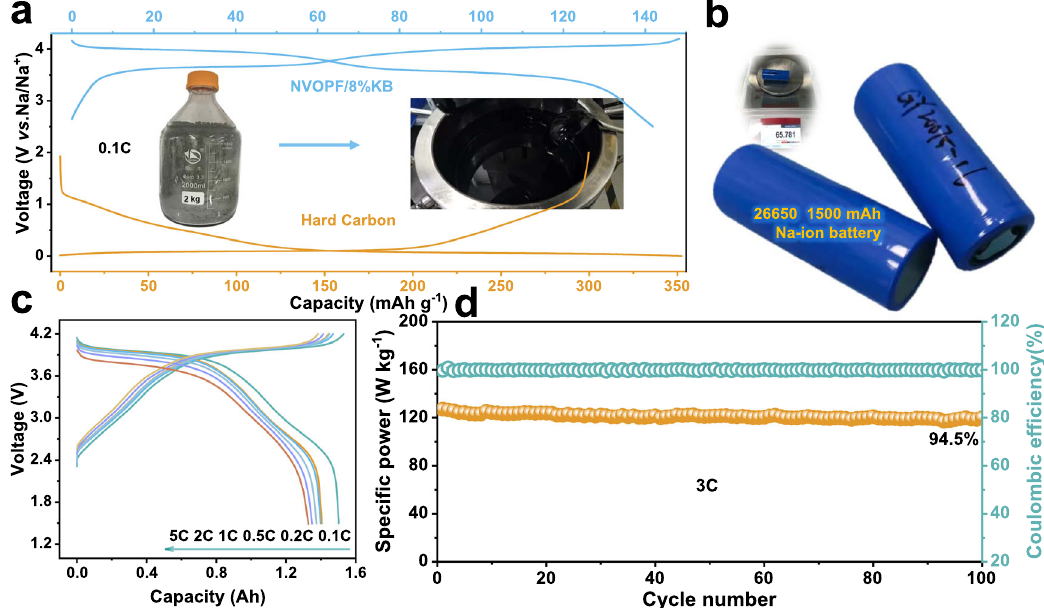
Fig. 5 Demonstration of large-scale production of NVOPF/KB composite and prototype 26,650 full-cell performance. a The charge – discharge pro fi les of mass-manufactured NVOPF/KB cathode and commercial hard carbon anode. Inset: the as-synthesized kilogram-scale NVOPF/8% KB products (left) and the preparation of the slurry (right). b Photograph of 26,650 prototype cells. Inset: the weight of a prototype 26,650 battery. c Rate capabilities of 26,650 cell from 0.1 to 5C. d Cycling performance of 26,650 cell at